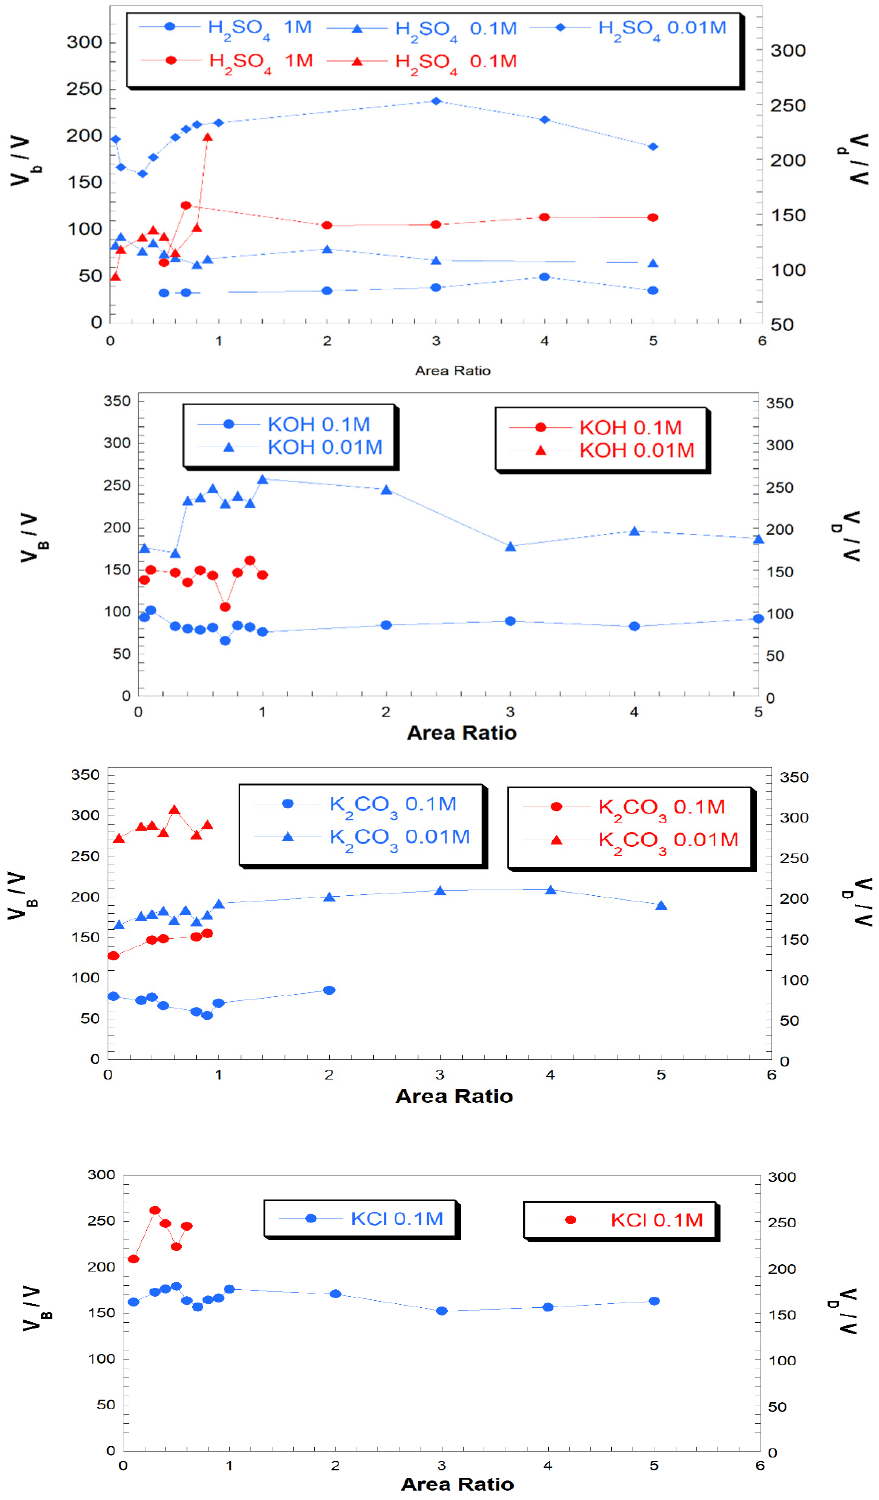
Figure 6. Trend of the characteristic CGDE parameters (VB, left y-axes in blue and VD, right y-axes in red) as a function of the cathode-to-anode ratio with different supporting electrolytes: H 2 SO 4 ( top ), KOH ( middle top ), K 2 CO 3 ( middle bottom ) and KCl ( bottom ). Different symbols refer to variable electrolyte concentration.